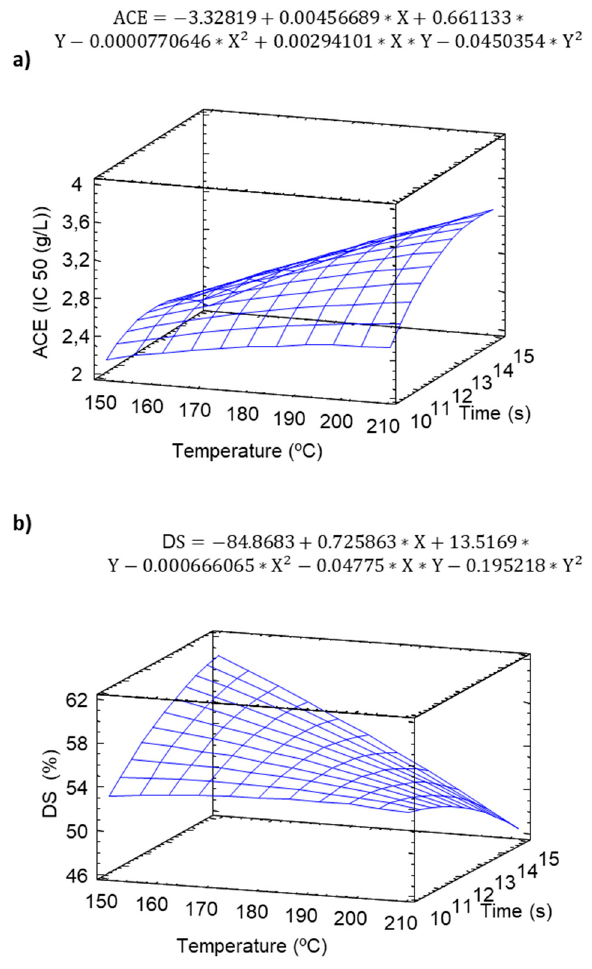
Figure 6. Response surface model of the effect of temperature and time on ( a ) angiotensin converting enzyme (ACE) and ( b ) Digestible Starch (DS) of pulse snacks.